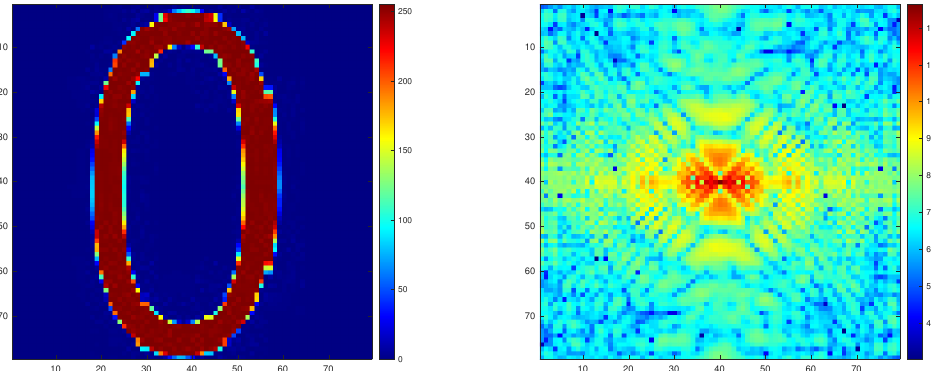
Figure 2. Spatial domain and spectral domain of digit